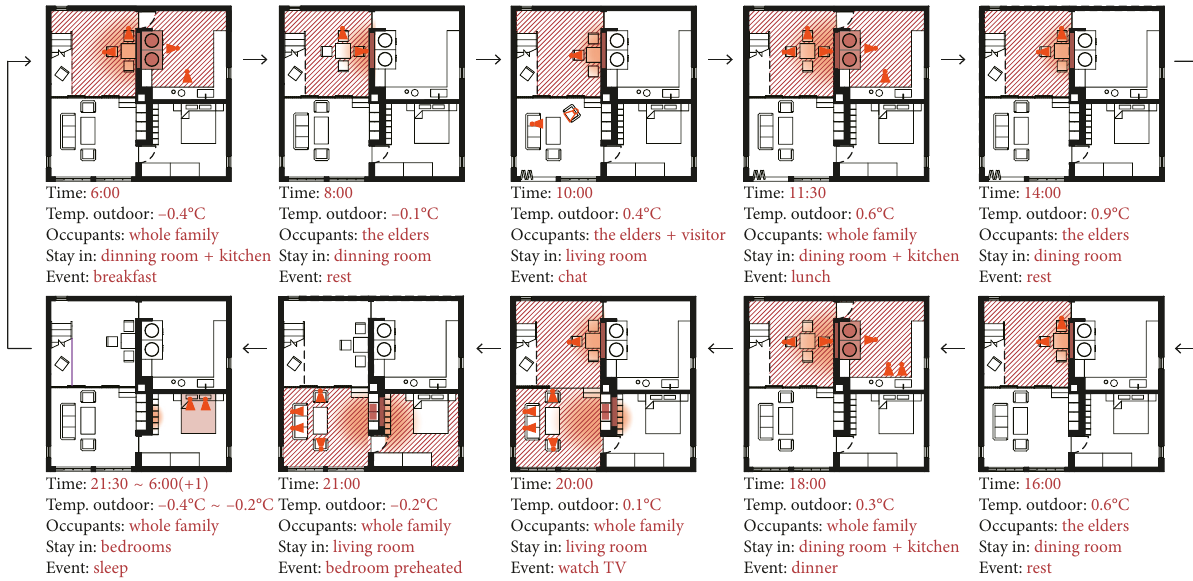
Figure 5: Prototype layout for applying the heat recovery system (winter